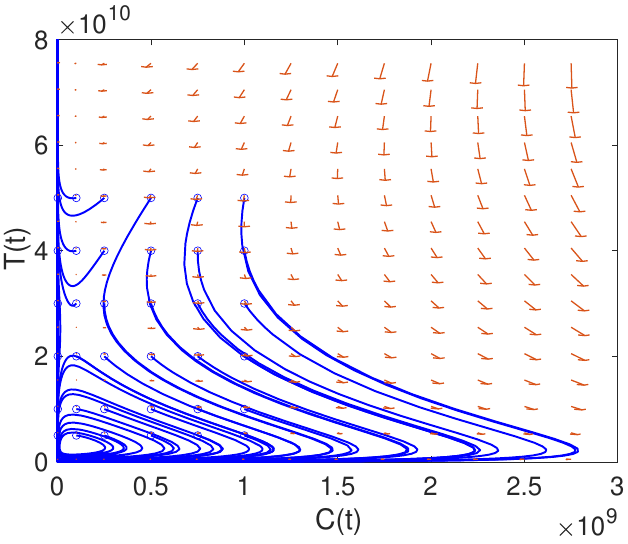
Figure A1. Phase space of model Equations (1) and (2). Some dynamics are represented as trajectories in the two-dimensional space (C(t),T(t)) (CAR-T cells, tumour cells) for default parameter values τ C = 7 days, ρ C = 0.9 day − 1 , ρ T = 1/50 day − 1 , α 1 = 0.04 day − 1 cell − 1 , α 2 = 2.5 × 10 − 10 day − 1 cell − 1 , g T = 10 10 and g C = 2 × 10 9